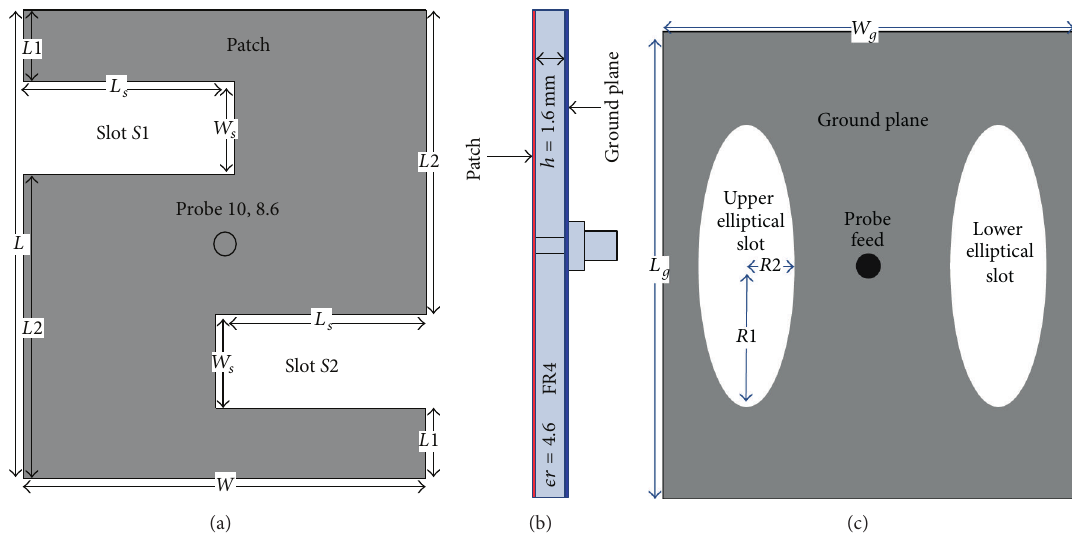
Figure 1: Proposed antenna geometry: (a) top view, (b) side view, and (c) bottom view.